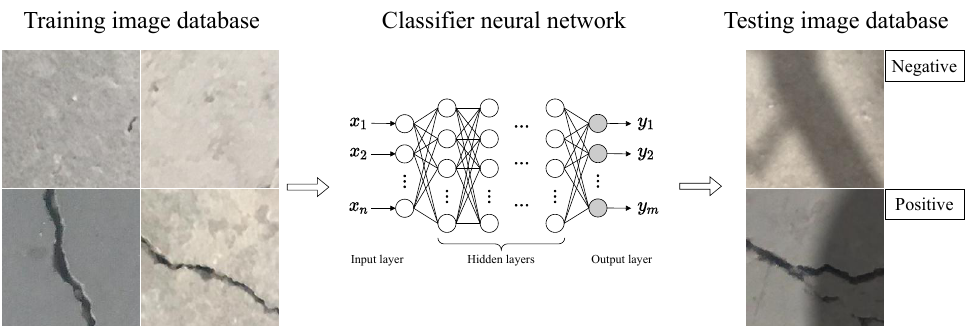
Figure 4. The schematic diagram illustrating the concept of the applied methodology for the detection of concrete cracks based on deep-learning techniques.